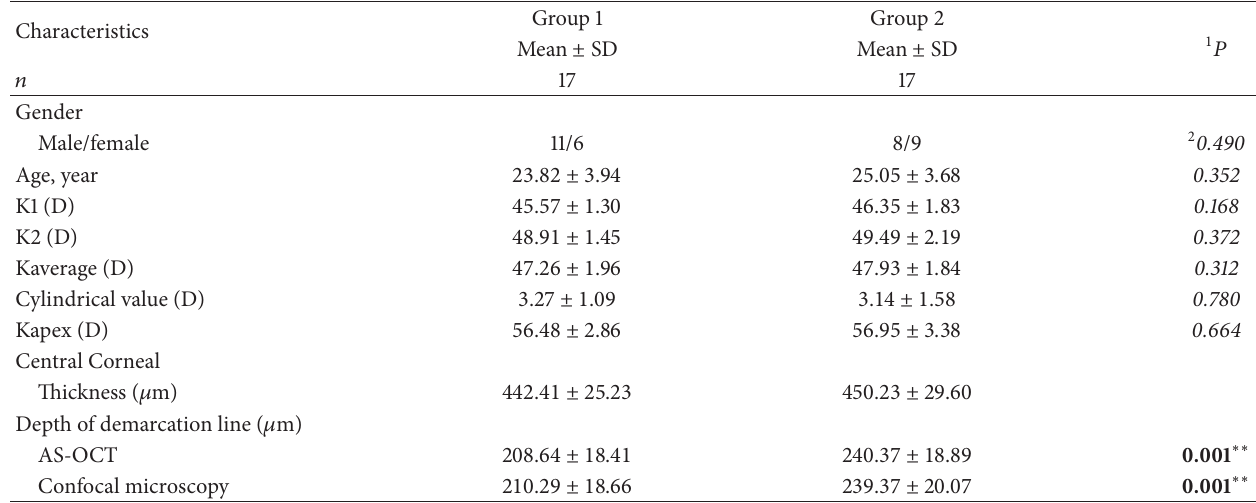
Table 1: Evaluation of the parameters between